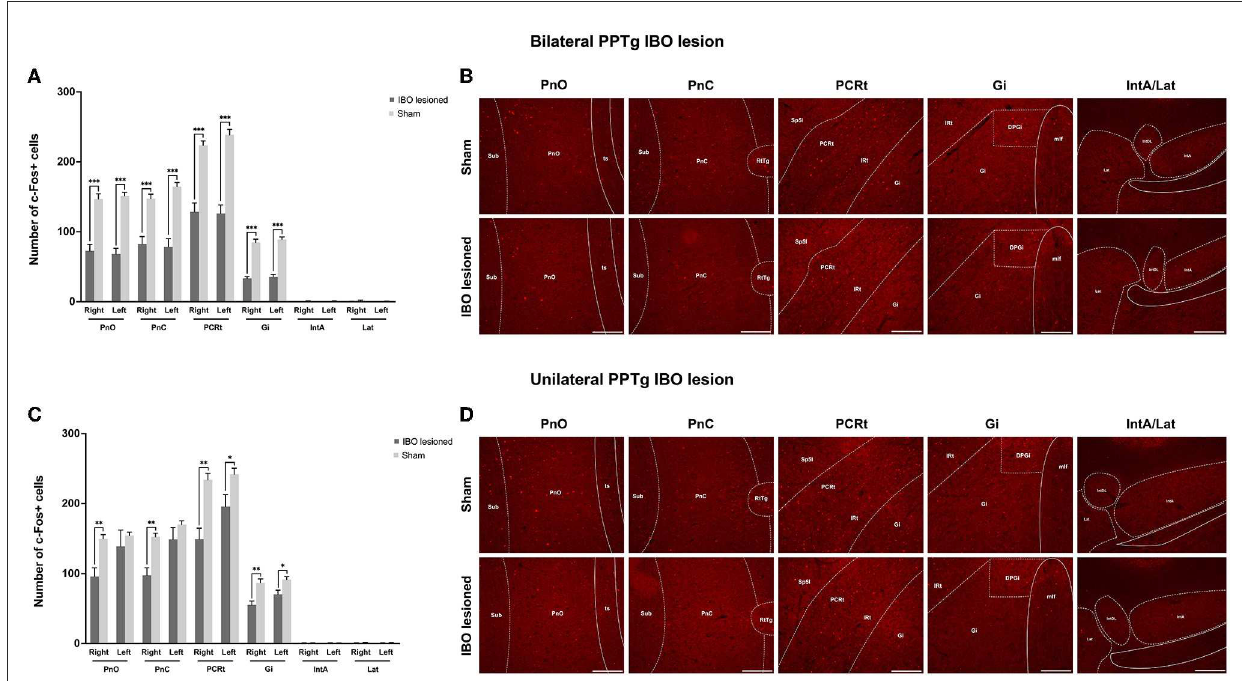
FIGURE10 Alterations of the neural activity in the reticular formations and cerebellar structures following the PPTg IBO lesion. (A) Significantly reduced neural activity was found in the bilateral PnO, PnC, PCRt, and Gi, while no change was observed for the bilateral cerebellar nuclei of IntA and Lat after the bilateral lesion. (B) Representative photographs of c-Fos + cells in the right PnO, PnC, PCRt, Gi, and IntA/Lat following the bilateral lesion. (C) Significantly reduced neural activity was found in the PnO (right), PnC (right), PCRt (bilateral), and Gi (bilateral), while no change was observed for the PnO (left), PnC (left), and bilateral cerebellar nuclei of IntA and Lat after the unilateral lesion. (D) representative photographs of c-Fos + cells in the right PnO, PnC, PCRt, Gi, and IntA/Lat following the unilateral lesion. * P < 0.05, ** P < 0.01, *** P < 0.001. Scale bar = 1000 µ